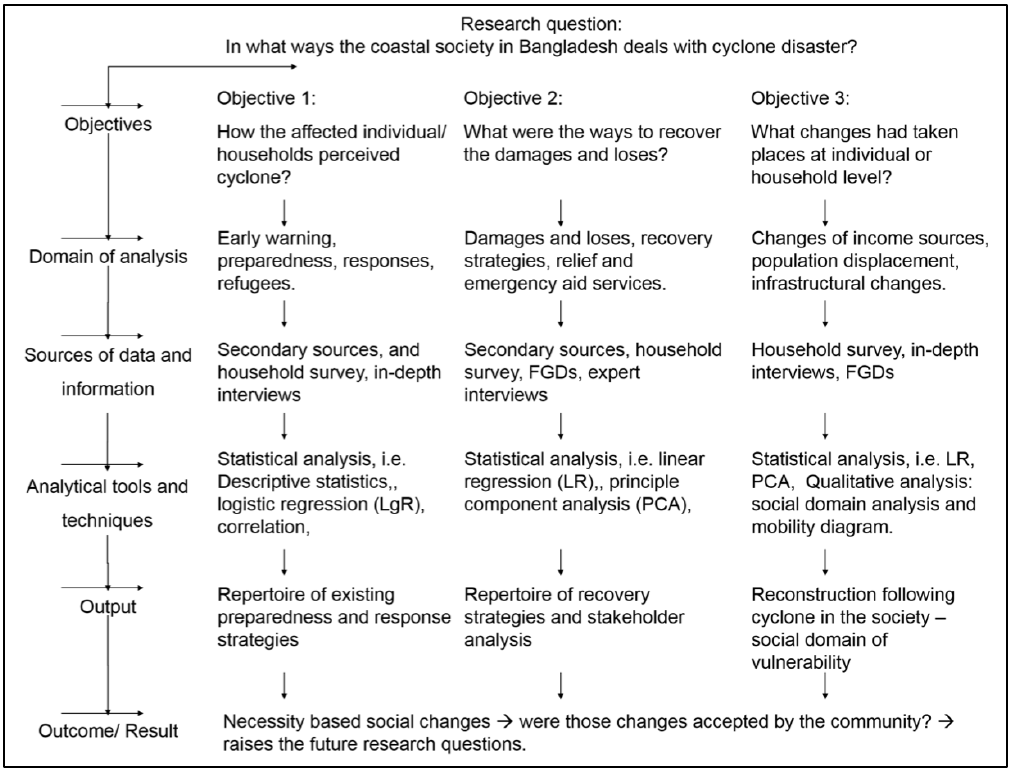
Figure 1. Methodological flowchart of the study.